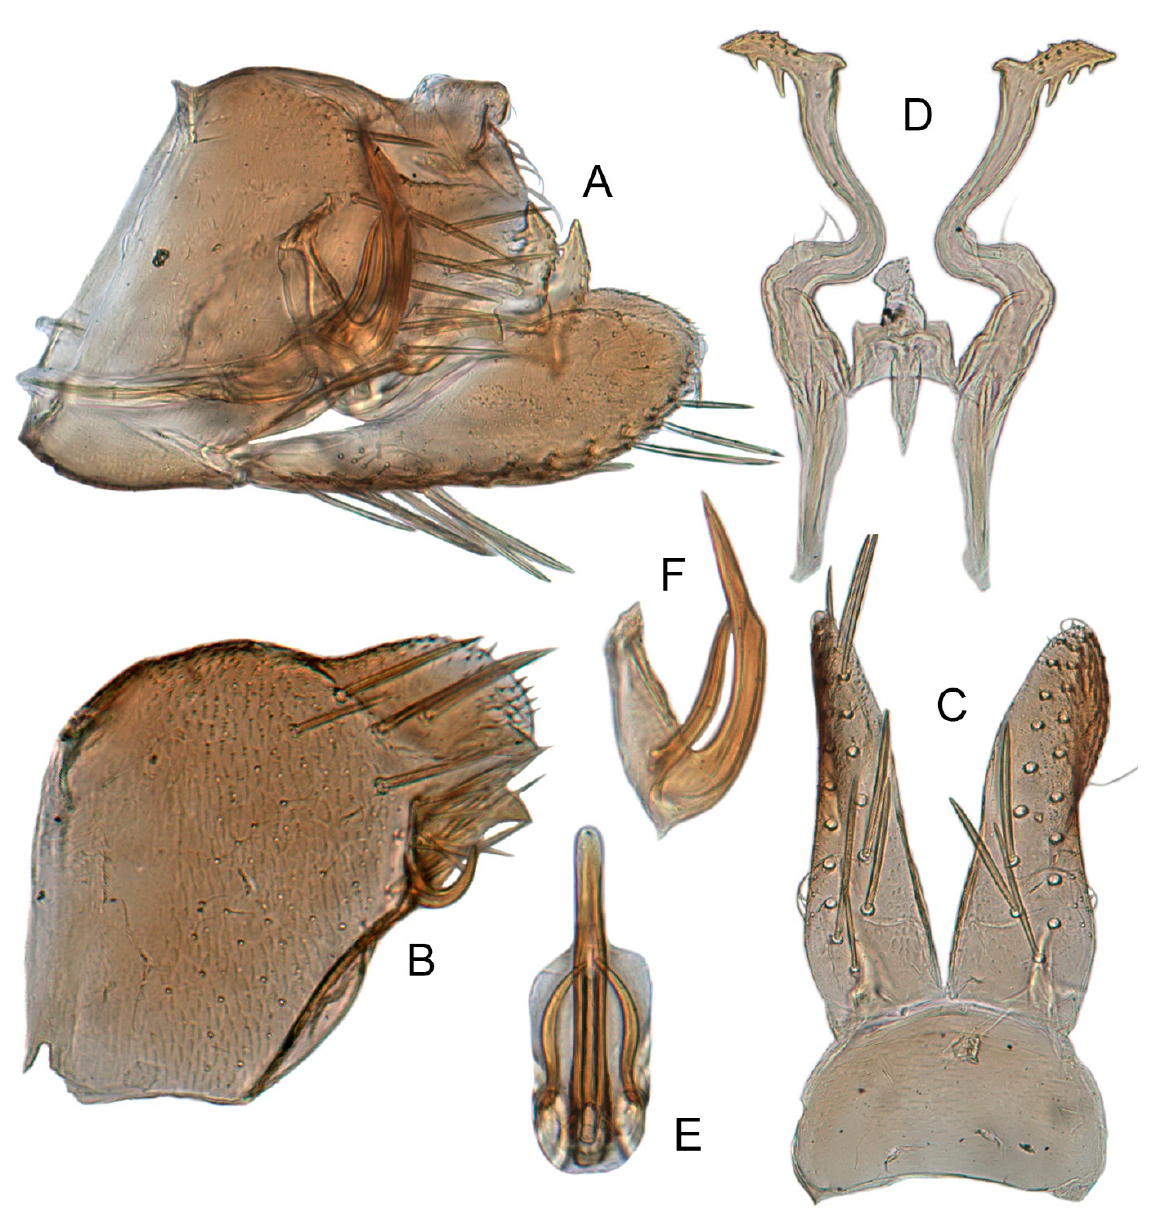
Figure 20. Xestocephalus recipinams sp. nov. ( A ) Male genital capsule, lateral view; ( B ) pygofer lobe, lateral view; ( C ) sub- genital plates and valve, ventral view; ( D ) style and connective, ventral view; ( E ) aedeagus, posterior view; ( F ) aedeagus, lateral view.